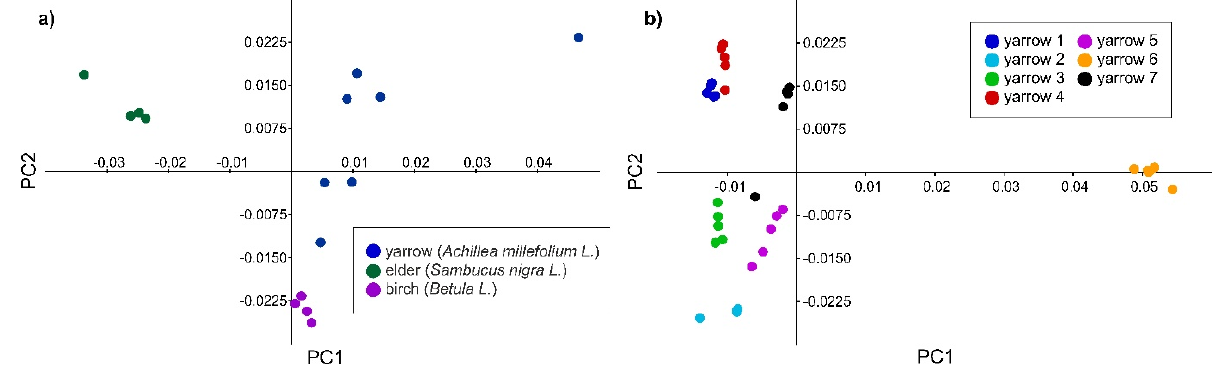
Figure 5. Principal Component Analysis (PCA) score plots for the filtered ESI-DIMS mass spectra of ( a ) the different herbs (variance % PC1: 43.4%, PC2: 31.5%), ( b ) different brands of yarrow (variance % PC1: 66.0%, PC2: 32.0%).